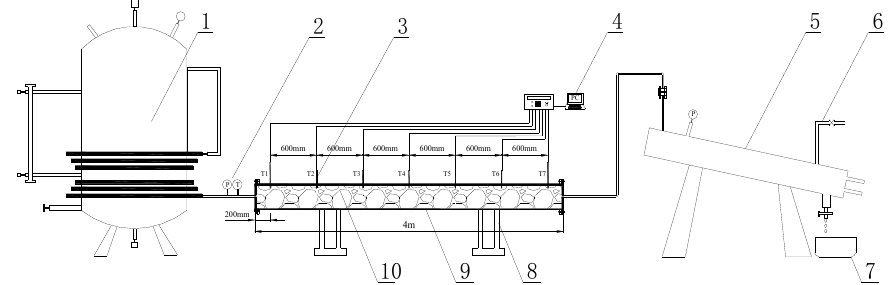
Figure 2. High-temperature steam pyrolysis testing system: (1) steam generator; (2) temperature and pressure sensors; (3) temperature sensors; (4) data acquisition system; (5) cooling system; (6) gas vent; (7) condensate and shale oil collector; (8) support frame; (9) pyrolysis reaction chamber; (10) oil shale samples .